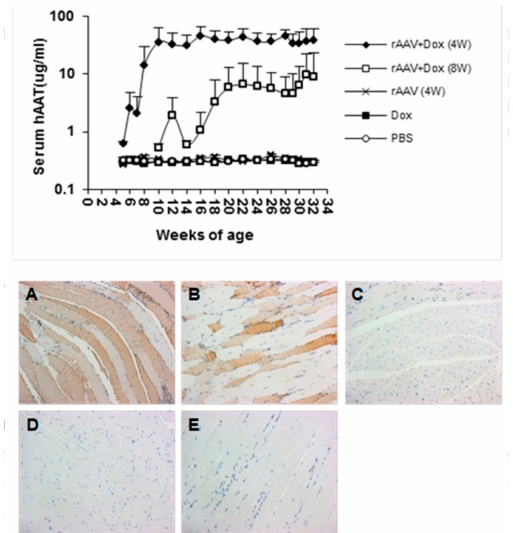
Figure 3. Transgene ( hAAT ) expressed from rAAV1-tet-on-hAAV in non-obese diabetic (NOD) mice. Top panel: serum hAAT levels detected by ELISA. Bottom panel: representative images of immunostaining for hAAT. Muscle sections from di ff erent groups: ( A ) rAAV + Dox (4 W) mice received rAAV vector and Dox-containing food ( n = 11); ( B ) rAAV + Dox (8 W) mice received rAAV and Dox ( n = 6); ( C ) rAAV (4 W) mice received rAAV only, without Dox ( n = 10); ( D ) Dox mice received Dox alone without rAAV vector ( n = 11); ( E ) Mice received phosphate-bu ff ered saline (PBS) injections ( n =